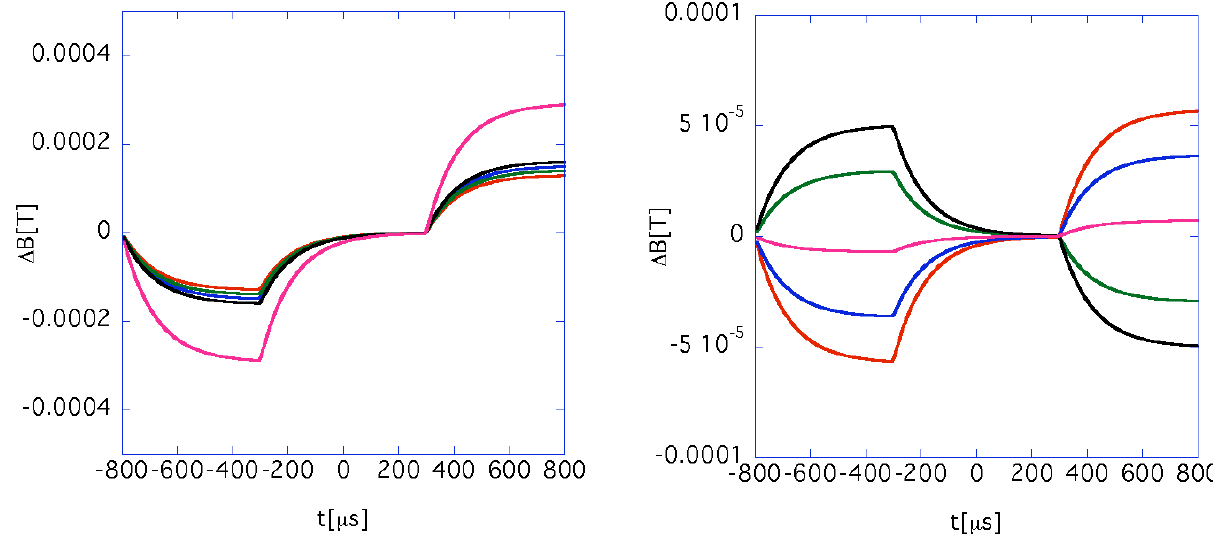
FIG. 14. (Color) The dependence of the field modulation at the center of the chamber on the number of Cu stripes, when the magnetic flux traverses the Cu stripes themselves. As a typical set of parameters, the radius of the chamber a ¼ 15 : 25 cm and the radius of Cu stripe b is 2.5 mm. The original magnetic flux changes as in Fig. 13 (analytical data). The right figure shows the theoretical results without the magnet yoke and the left figure does the results where the size of magnet yoke is specified as 2 h ¼ 2 g ¼ 32 : 0 cm . The red, blue, green, black, and pink lines represent the cases that 20, 40, 60, 80, and 100 stripes cover the chamber from the lower side. The 100 stripes corresponds to the case where the chamber is completely covered by Cu stripes. The field modulation might become the smallest when the chamber is completely or half covered by stripes when the effect of the yoke could be negligible, while it is the largest in reality in the case where the chamber is completely covered by the stripes due to ‘‘the effect of the yoke.’’